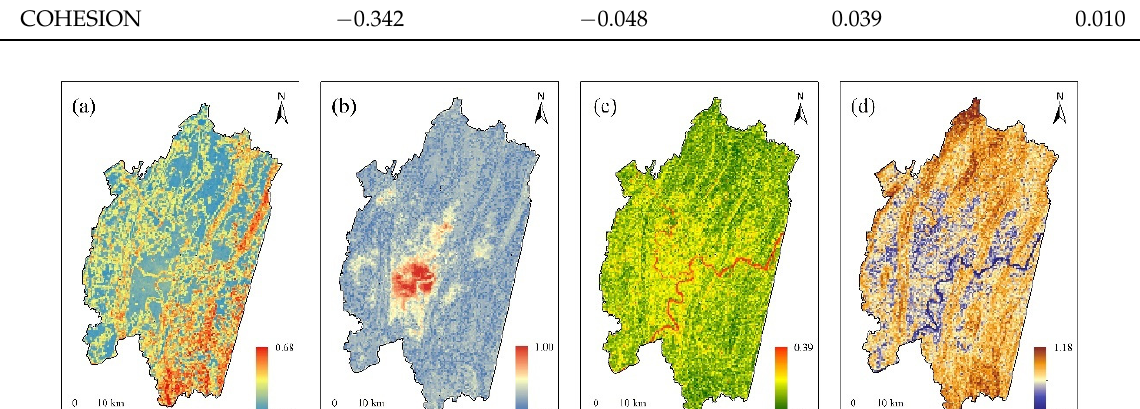
Figure 6. Spatial distributions of the first four principal components. ( a ) The first principal component, ( b ) the second principal component, ( c ) the third principal component, ( d ) the fourth principal component.